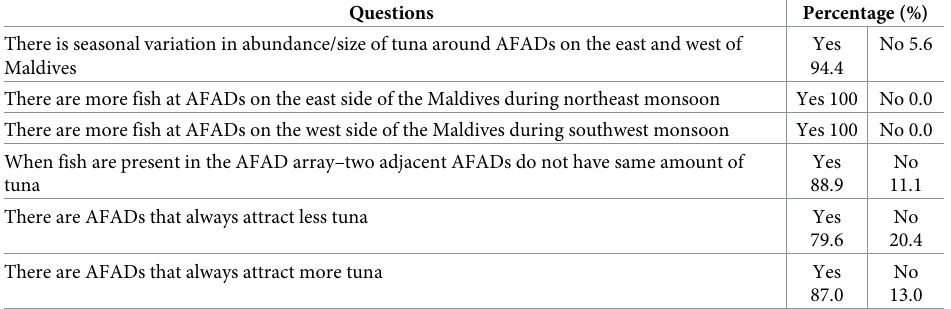
Table 1. Fishers’ response to seasonal variation and association behaviour of tuna at AFADs, at the scale of the AFAD array.